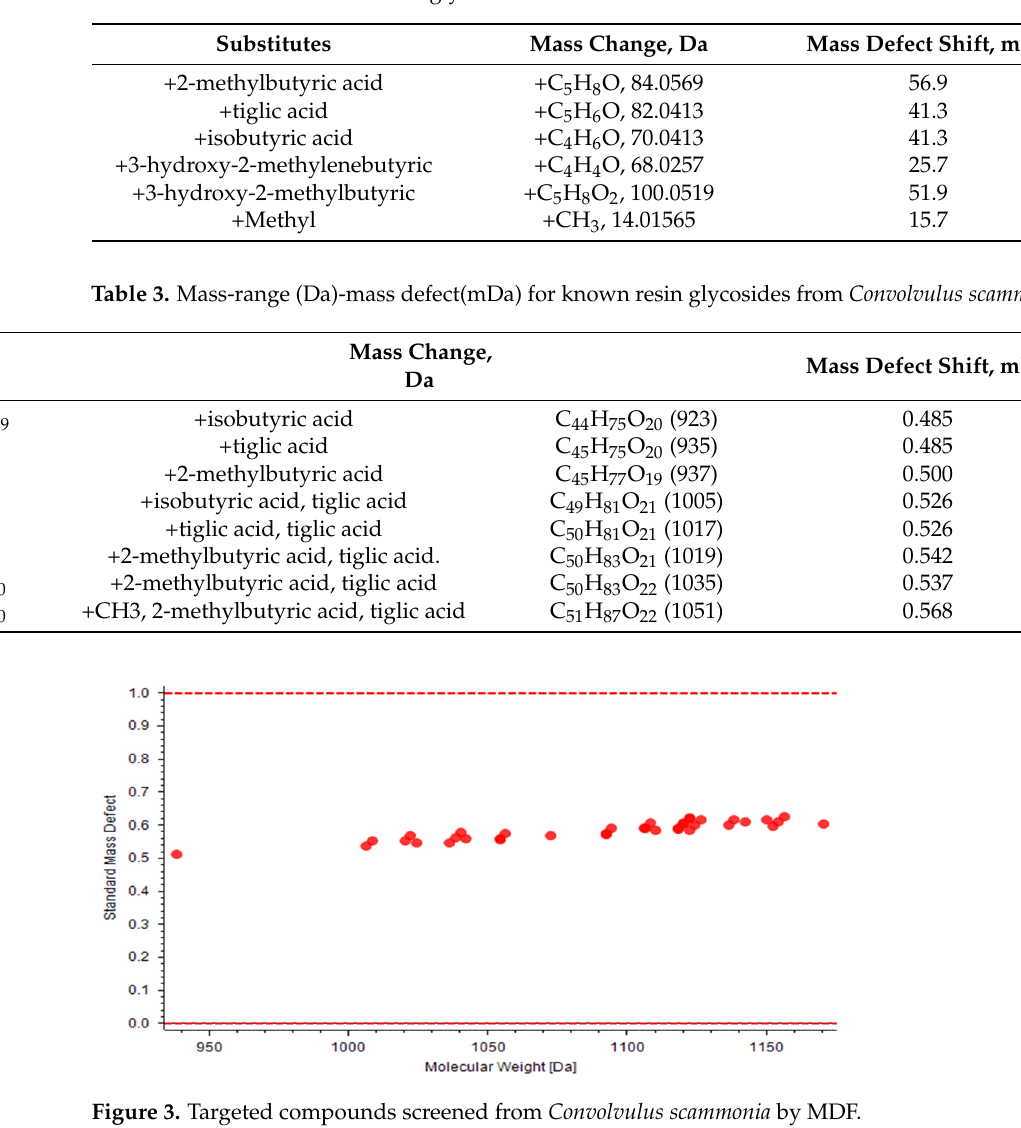
15.7 Table 3. Mass-range (Da)-mass defect(mDa) for known resin glycosides from Convolvulus scammonia. Filters